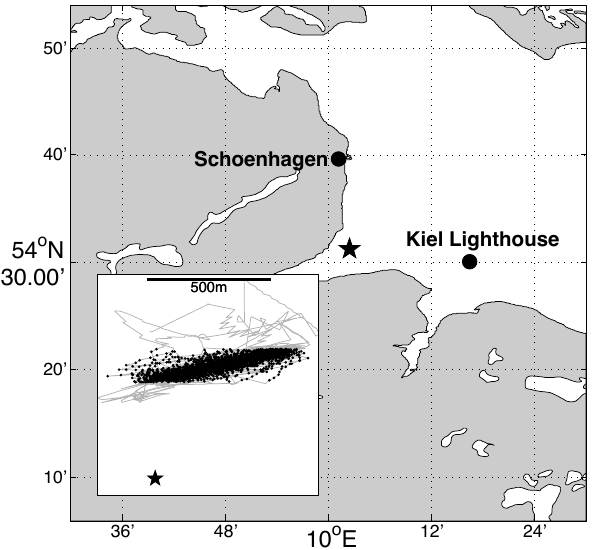
Figure 1. Overview map with Boknis Eck time-series station (black star) and the meteorological station Schönhagen and Kiel light- house. All glider tracks (grey lines) and the positions of glider ob- servations used in this study (black dots) are shown in the